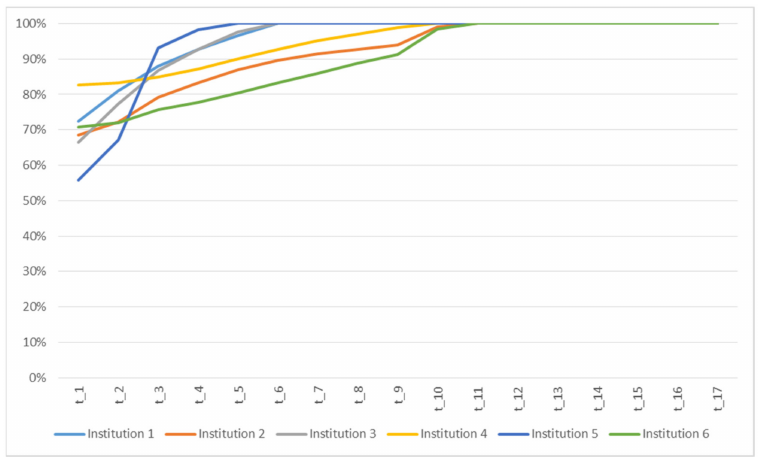
Figure 3. Unexpected loss add-on of the Spanish institutions by time in default.